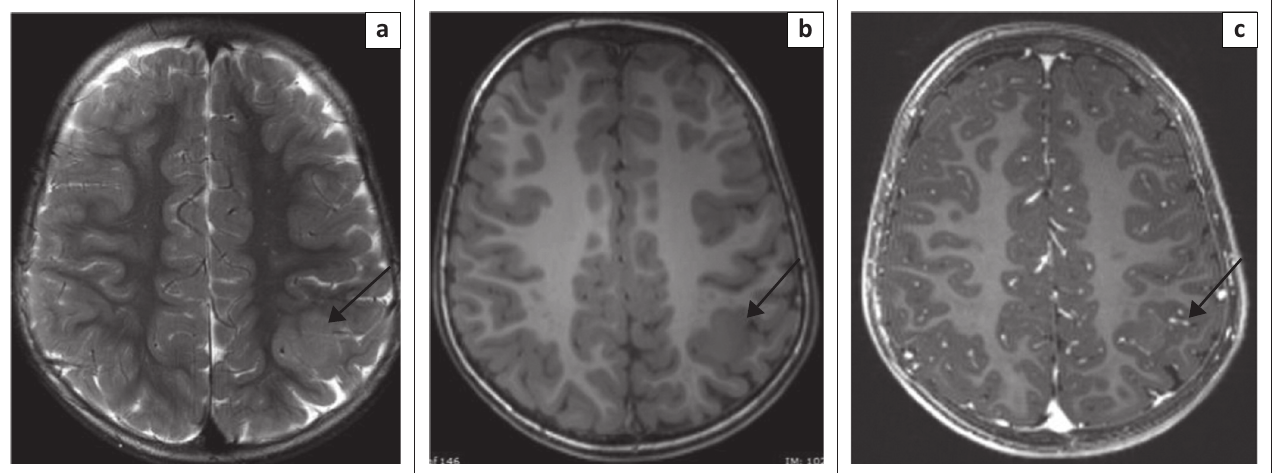
FIGURE 8: Three-year-old boy presenting with new onset seizures. Axial T2W (a), MPRAGE (b) and contrast-enhanced MPRAGE (c) demonstrate focally thickened cortex in the left parietal lobe with slightly T2 hyper- and T1 isointense signal of the thickened cortex in the left postcentral gyrus (arrows). Although this could be a focal cortical dysplasia, the presence of blush of enhancement (arrow) on the contrast-enhanced sequence (c) raises concerns of a neoplastic process. Pathology of the resected specimen (after initial biopsy) showed an angiocentric